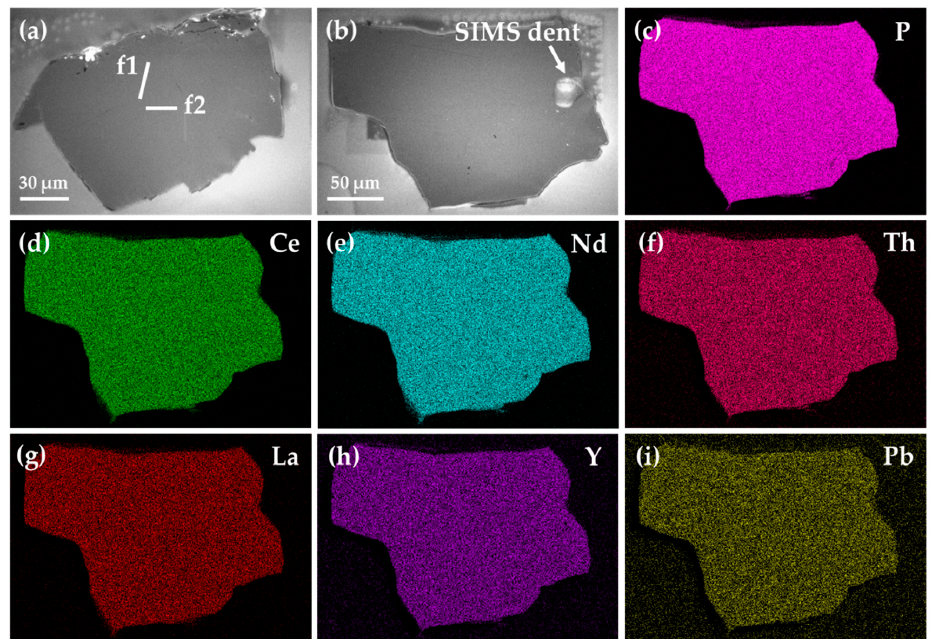
Figure 2. ( a ) and ( b ) are the cathodoluminescence images of two monazite chips. Two white bars in ( a ) show the sites of two focused ion beam (FIB) foils (f1, f2). ( c – i ) The corresponding energy-dispersive X- ray spectrometer (EDS) maps of the monazite chip in ( b ) after the secondary ion mass spectrometry (SIMS) dent was